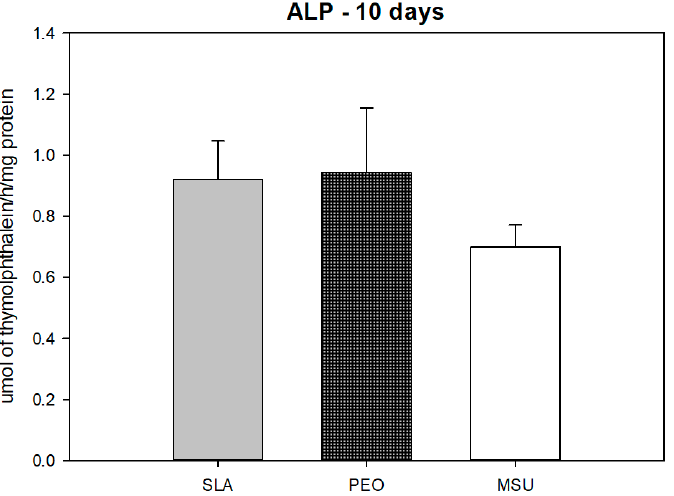
Figure 5. Alkaline phosphatase activity for SLA, PEO and MSU surfaces ( p = 0.859), showing a similarity in the results.